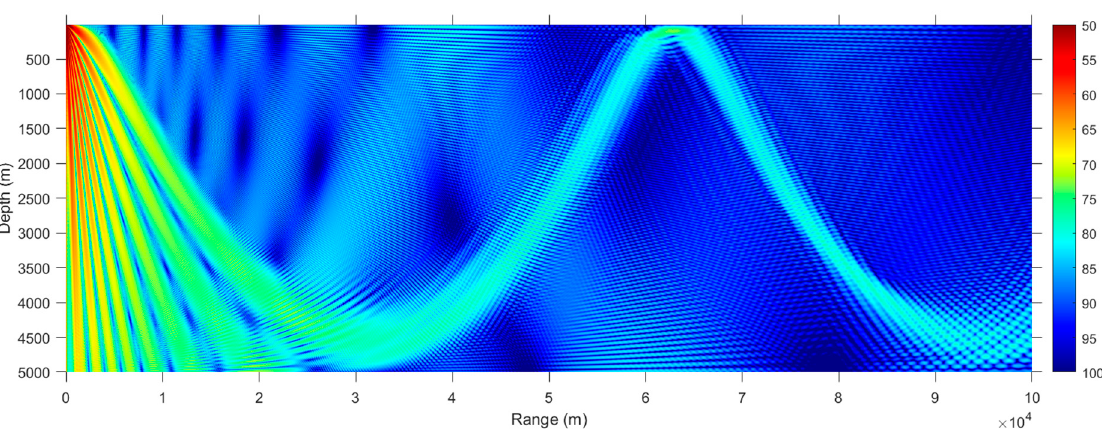
Figure 10. The TL contour in the Munk waveguide case using the NFD with PPW = 6. Furthermore, the computation time of KrakenC (mainly including the calculation of the eigenvalues and eigenfunctions, not including the calculation of the sound pressure field) can be significantly reduced using the NFD with smaller PPW numbers. In the Munk waveguide case, the computation time of KrakenC using the NFD with PPW = 6 and SFD with PPW = 10, 20 is 0.297 s, 0.375 s, and 0.703 s, respectively, meaning that the modified KrakenC using the NFD ( PPW = 6) runs more than twice as fast as the original KrakenC using the SFD ( PPW = 20) when their results have comparable